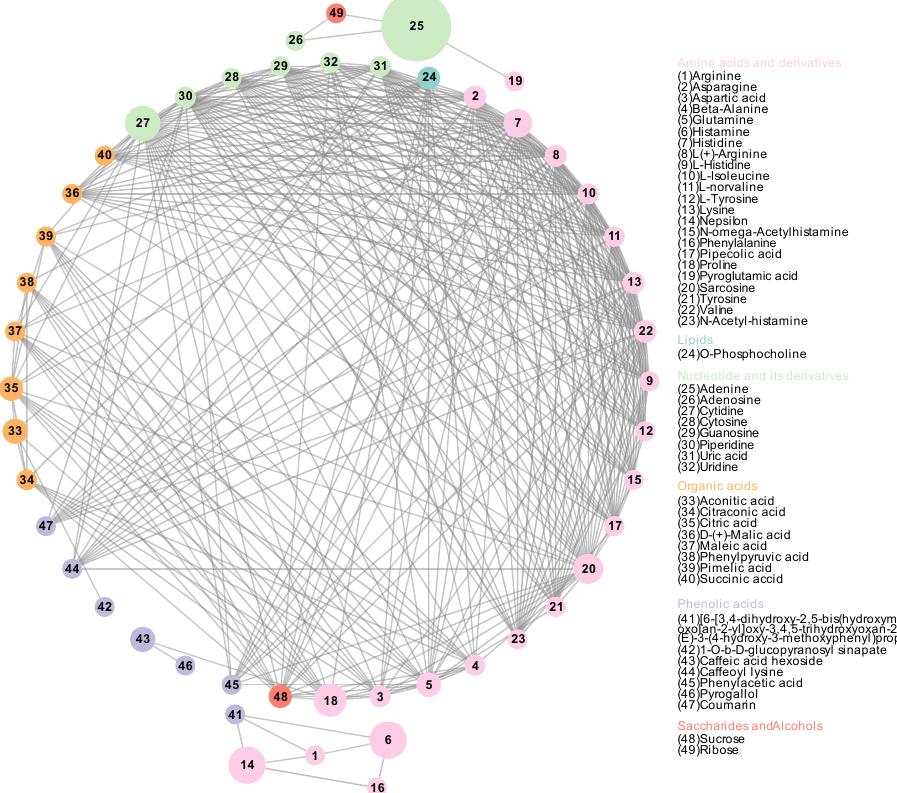
Figure 2. Each metabolite node is sized based on its betweenness centrality. The thickness of the line connecting the metabolites is indicated by the weighted value (Tables S5 and S6). Identification of each metabolite is indicated by a number in the legend.